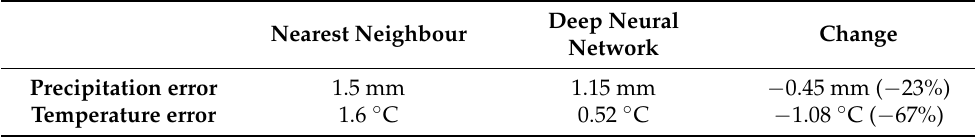
Table 1. Mean absolute errors in weather interpolation. Deep Nearest Neighbour